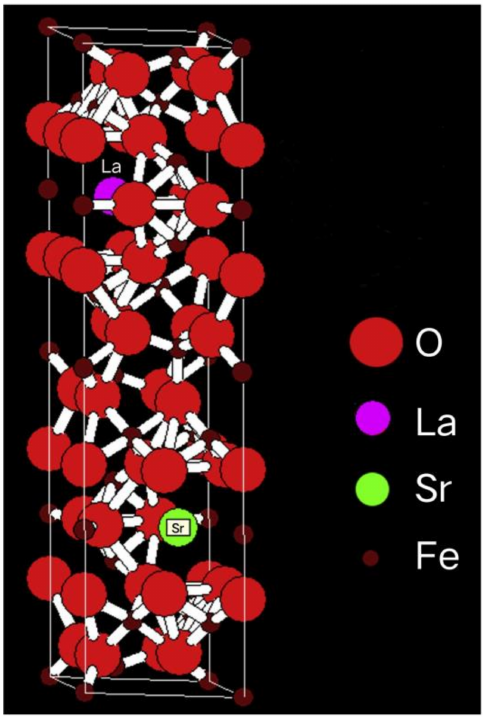
Figure 7. Schematic crystal structure of La 0.5 Sr 0.5 Fe 12 O 19 with space group